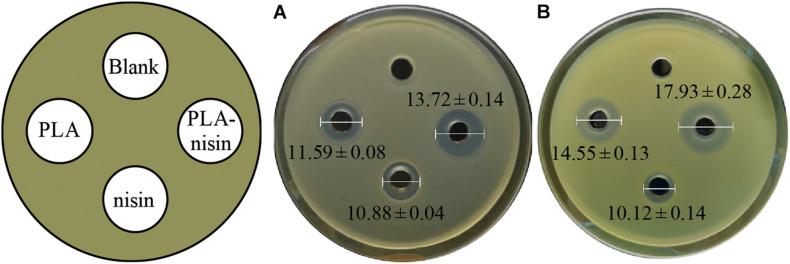
The antibacterial activities of PLA and nisin against S. xylosus
(A) and M. luteus
(B). The wells (6 mm) of the plates were added with 100 μL 0.02 M HCl as blank, 10 mg/mL PLA, 100 IU/mL nisin and a mixture of PLA-nisin with the same concentrations. The differences in inhibition diameters (unit: mm) represents bacteriostasis activities of PLA and nisin. The differences among the four groups were compared by One-way ANOVA. The diameter of inhibition zone of PLA-nisin was significantly different (P < 0.01) compared with PLA, nisin and control.